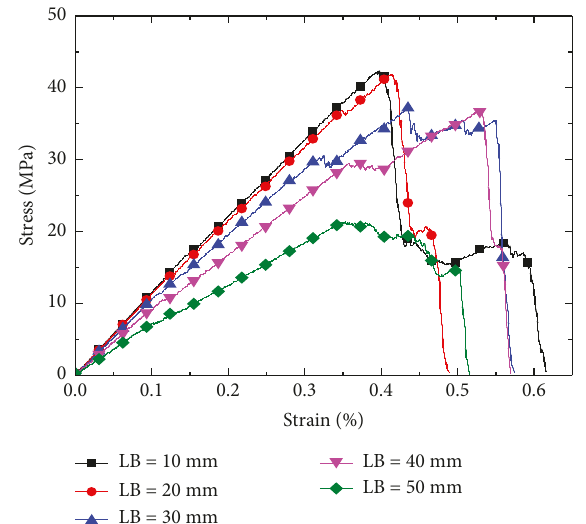
Figure 6: Stress-strain curves of rocks with different joint